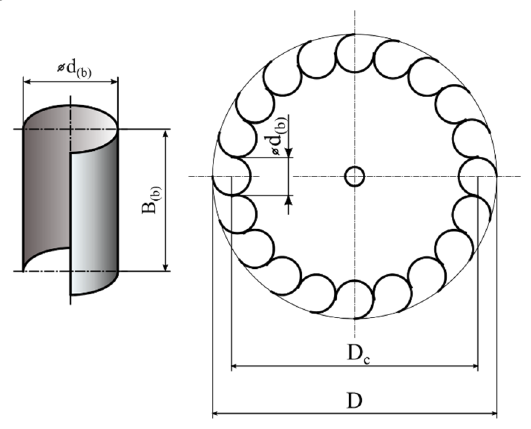
Fig. 1. Bucket and water wheel shape